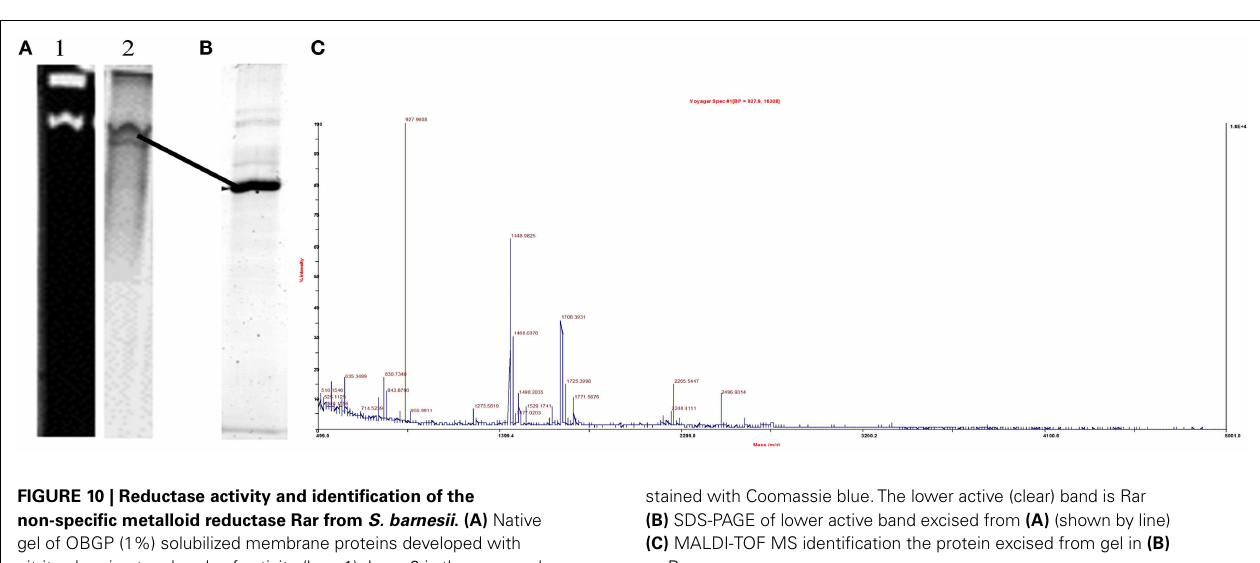
FIGURE 10 | Reductase activity and identification of the non-specific metalloid reductase Rar from S. barnesii . (A) Native gel of OBGP (1%) solubilized membrane proteins developed with nitrite showing two bands of activity (lane 1). Lane 2 is the same gel